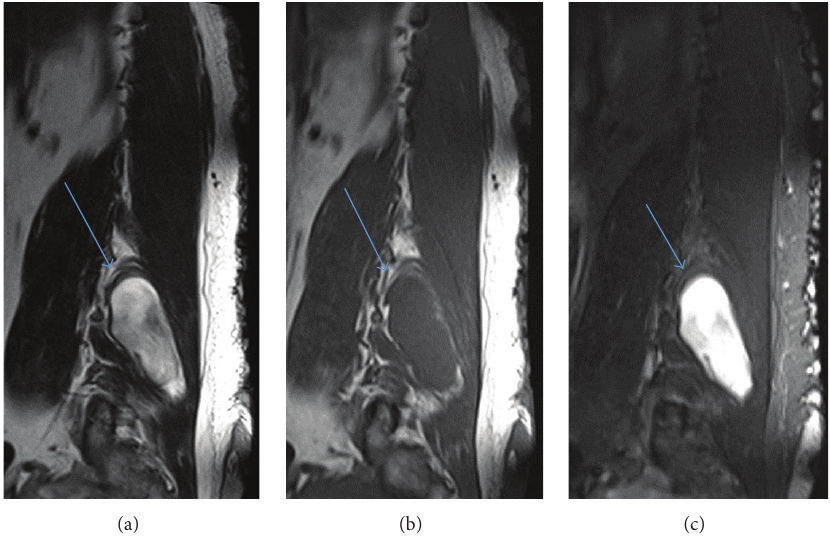
Figure 3: (a) Sagittal T2 shows right erector spinae/multifidus muscle neurofibroma (arrow). (b) Sagittal T1 shows right erector spinae/multifidus muscle neurofibroma isointense to muscle (arrow). (c) Sagittal STIR shows right erector spinae/multifidus muscle neurofibroma (arrow). The neurofibromas on the skin surface are bright on STIR but not well seen on T2 (a) and T1